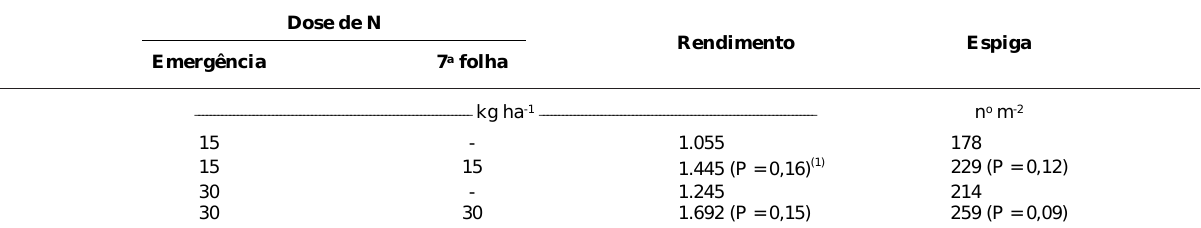
(1) Médias dentro da mesma dose de N na emergência diferem entre si